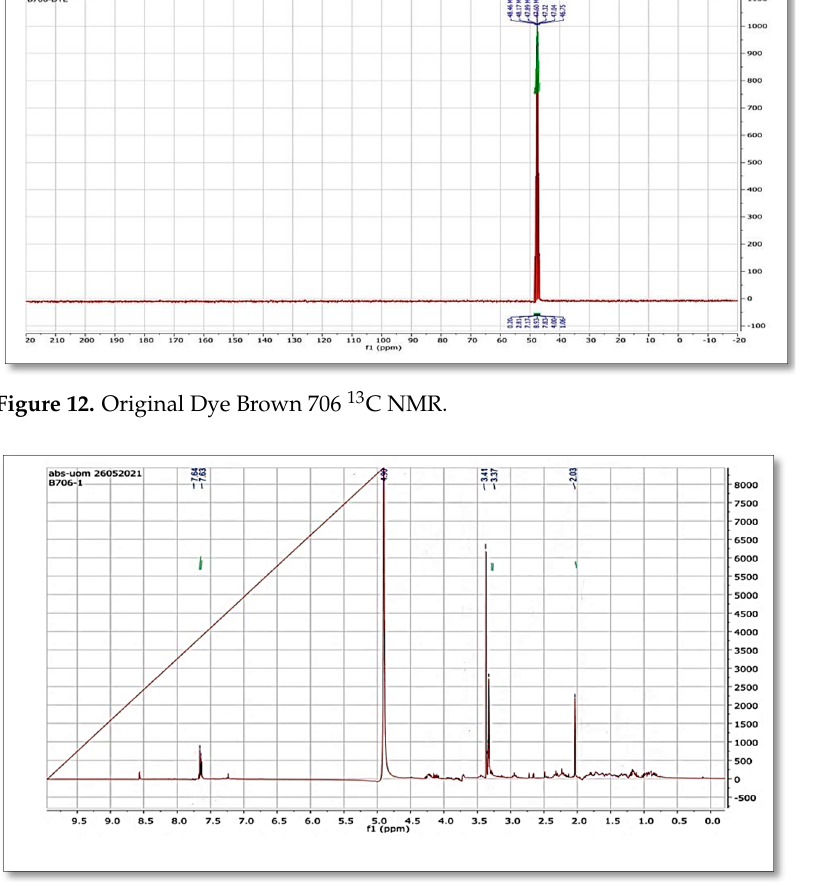
Figure 13. 1 H NMR after Pseudomonas aeruginosa degradation.